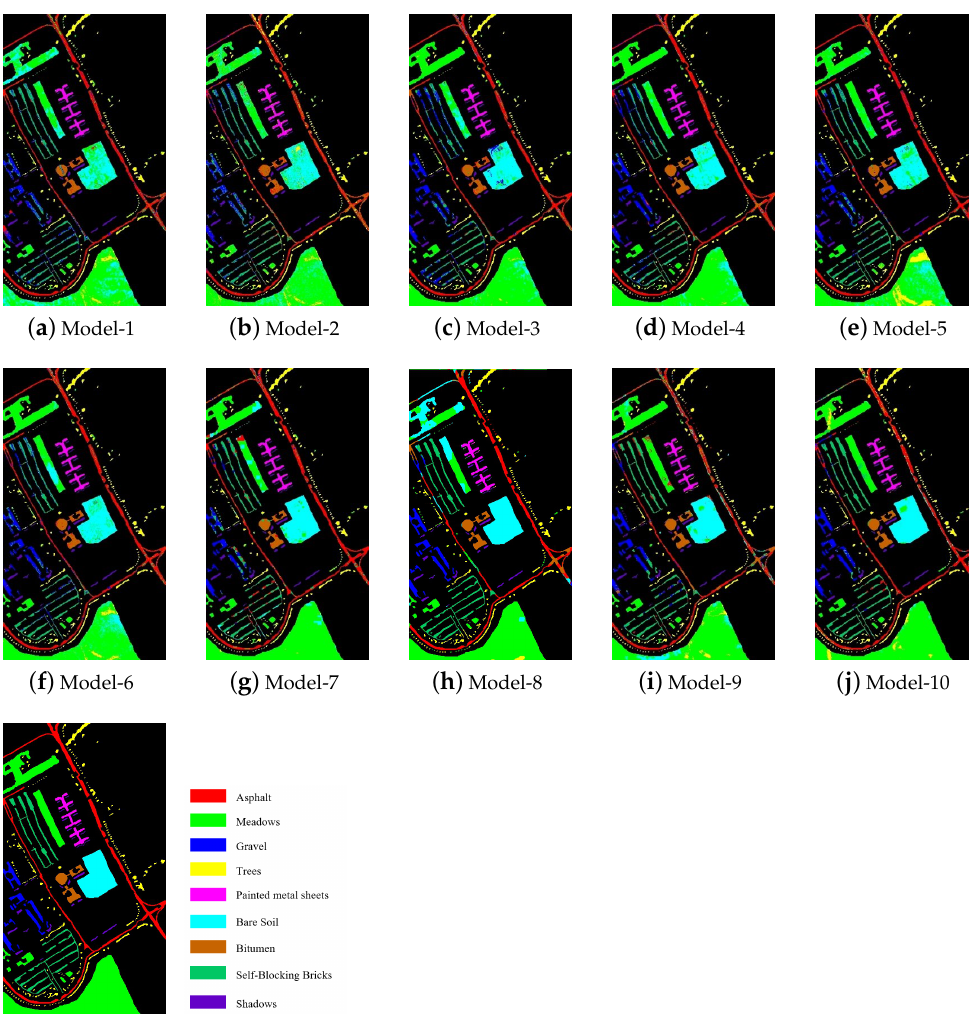
Figure 9. Classification maps of the models on the PaviaU